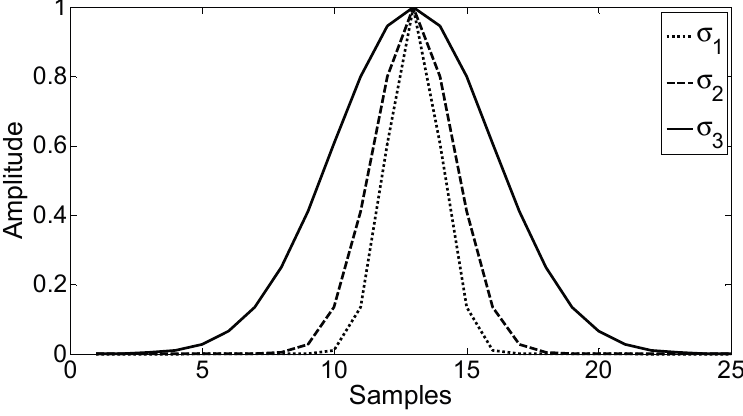
Figure 6. Gaussian windows used with the WMA